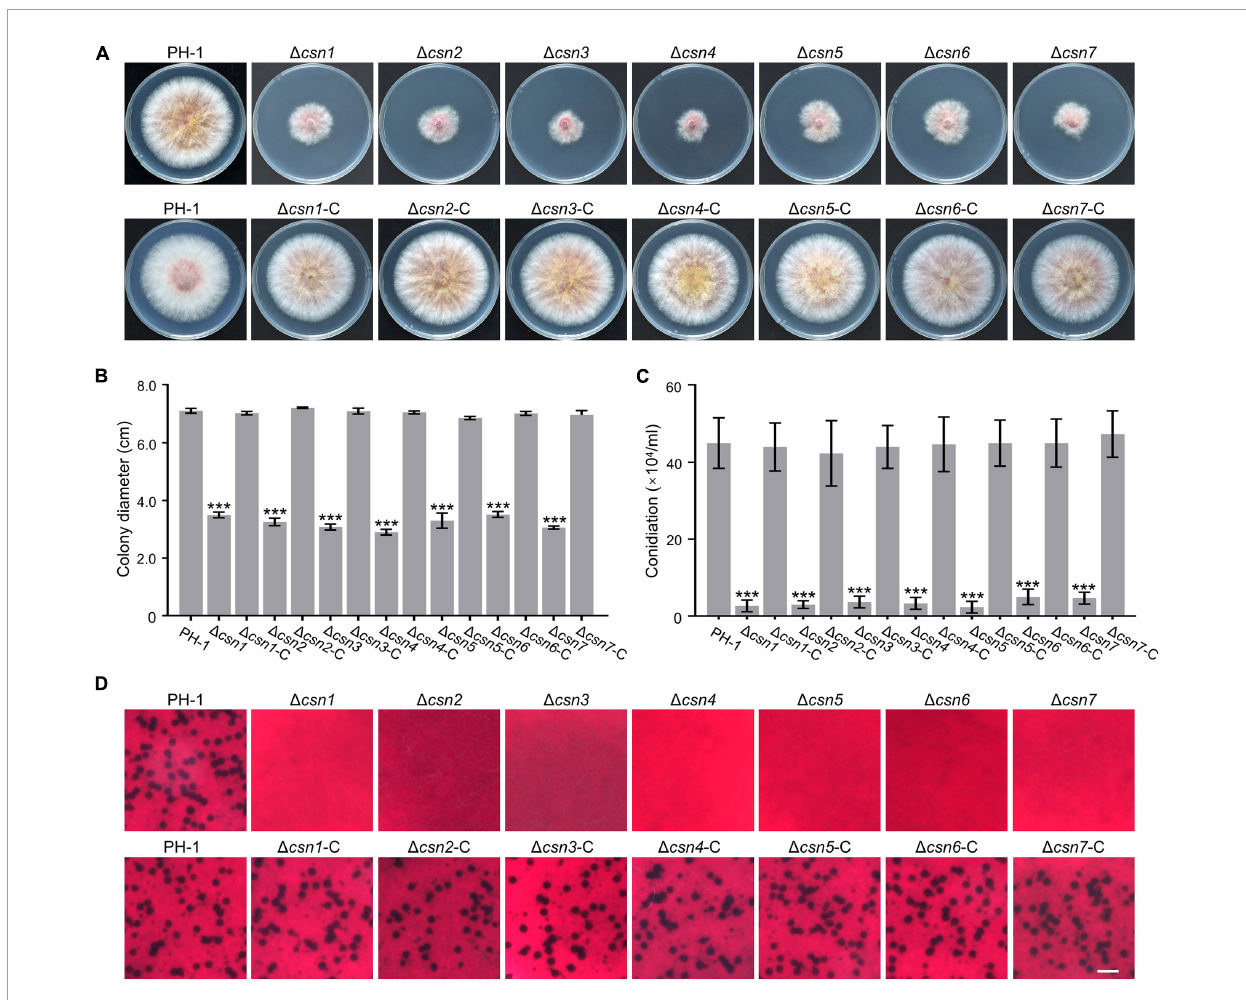
FIGURE4 The Csn complex is involved in the fungal development of F. graminearum . (A) Colony of each strain grown on potato dextrose agar (PDA) medium at 25 ◦ C for 3 days. (B) Bar charts showing the colony diameters of the indicated strains. (C) Bar charts showing the number of conidia produced by the tested strains in liquid CMC medium. (D) Micrographs showing the perithecial formation of the indicated strains after growth on carrot agar for 4 weeks. Bar = 1 mm. Error bars indicate the standard deviation from three independent experiments. Statistical analysis was performed via Student’s t -test. A triple asterisk indicates statistical significance with p <